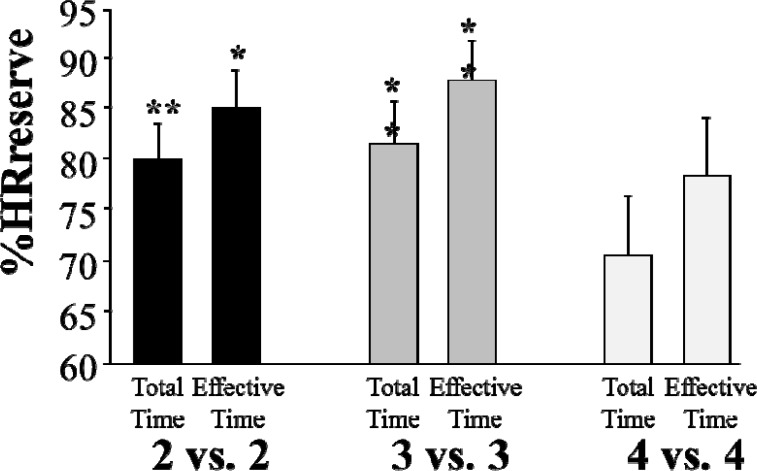
Percentage of heart rate reserve (%HRreserve) measured after 30s of recovery of 2 vs. 2, 3 vs. 3 and 4 vs. 4 small-sided games. *p<0.05 compared to 4 vs. 4.